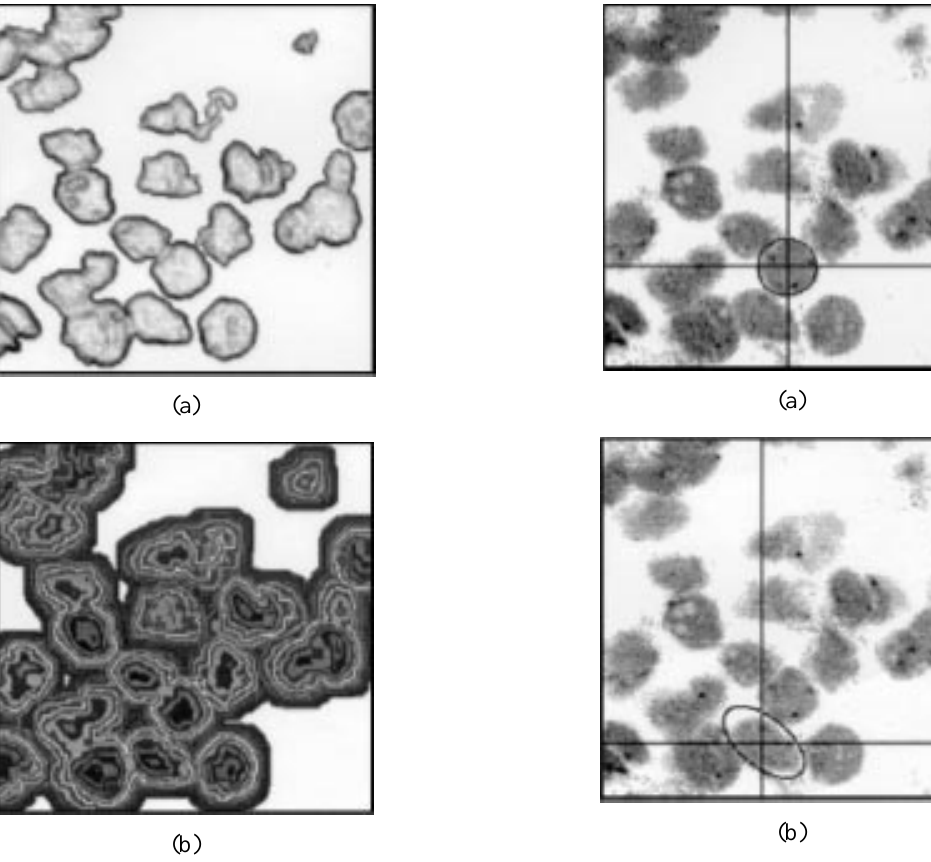
Fig. 5. (a) Circular cursor for adjusting lateral radii and orientation of initial model. (b) Elliptic cursor for adjusting lateral radii and ori- entation of initial